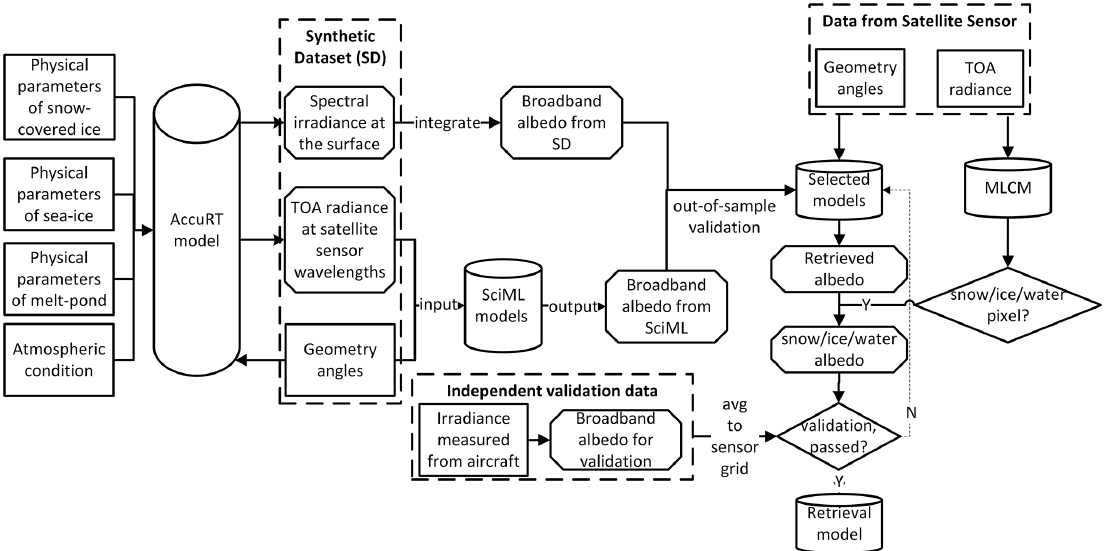
Figure 1. Flowchart of the proposed RTM–SciML framework for albedo